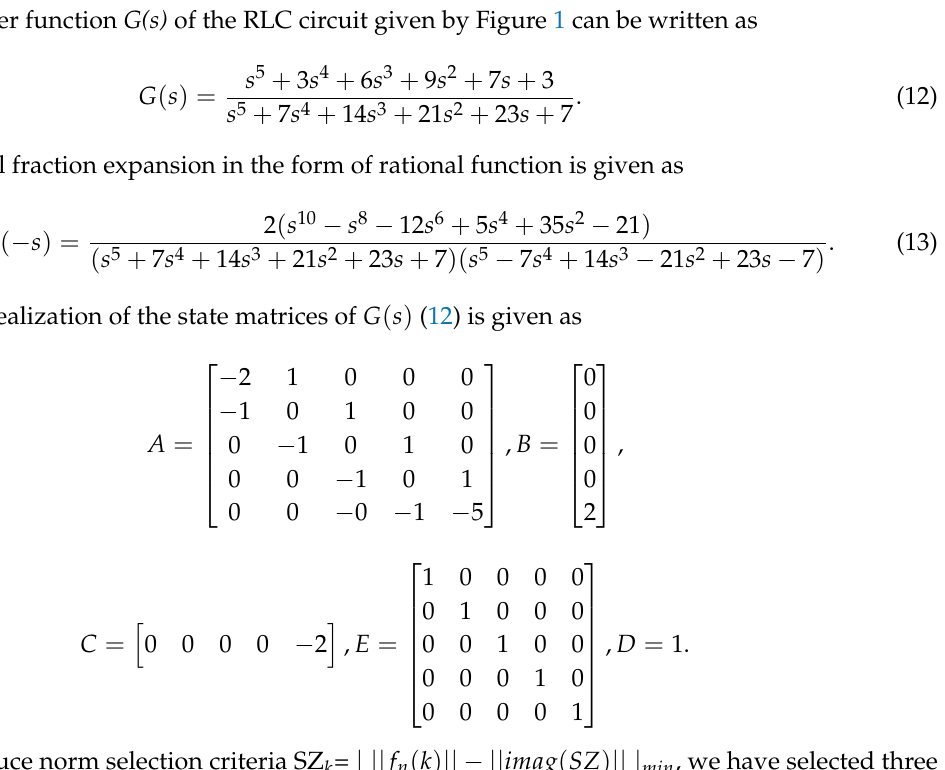
Figure 1. RLC ladder circuit consisting of resistors, inductors and capacitors forming a 5th order